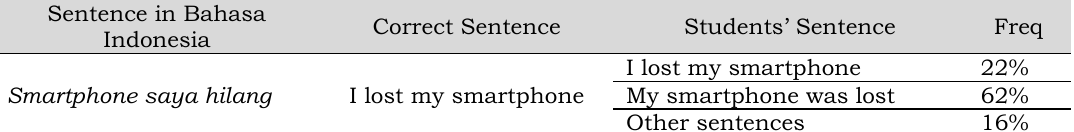
Table 3: The frequency of passive voice interference in the third